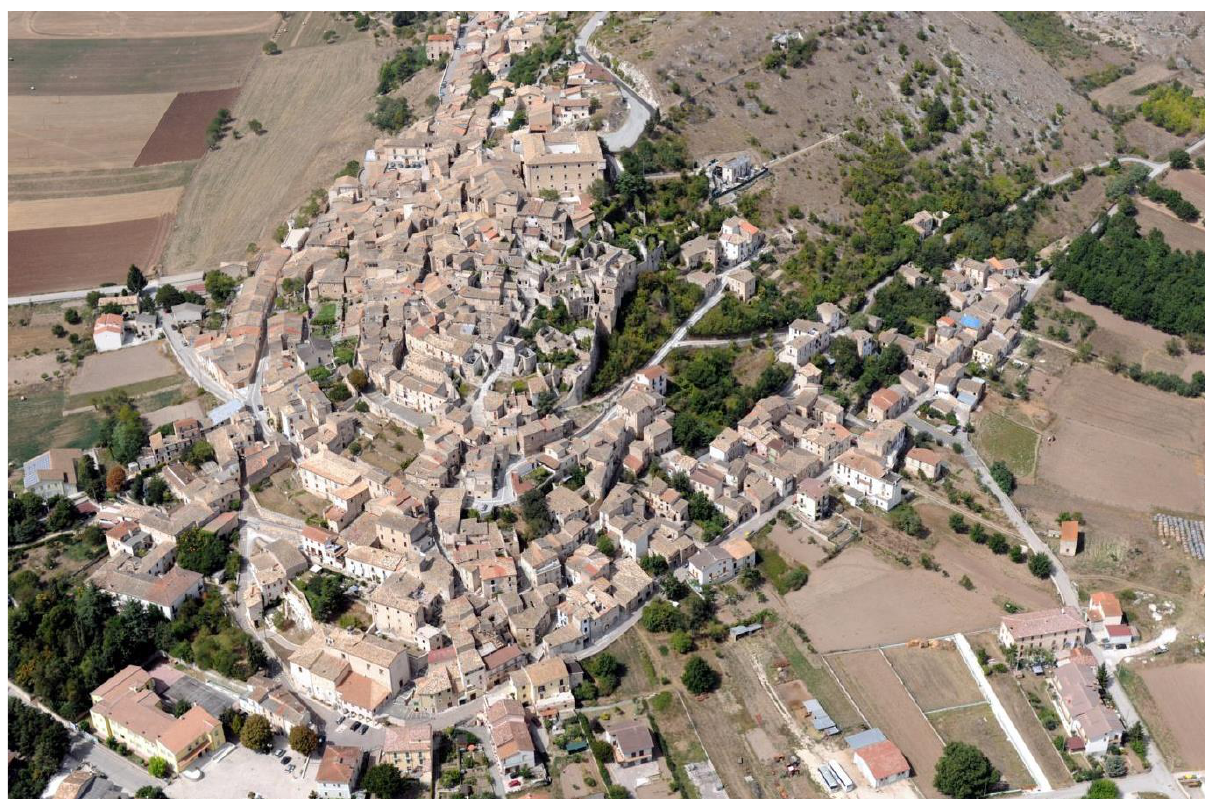
Figure 1. Aerial view of Navelli (photo: Report of the RdP, p.